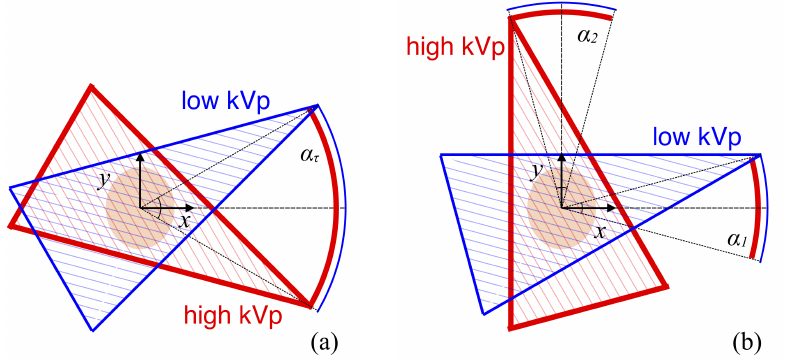
Figure 1. Schematics of SA ( a ) and TOA ( b ) scans of LARs in fan-beam DECT. The SA scan includes a pair of completely overlapping arcs of LAR α τ , and the x -axis intersects with the middle point of the two arcs, whereas the TOA scan includes two pairs of completely overlapping arcs of LARs α 1 and α 2 , and the x - and y -axis intersect with the middle points of the two pairs of arcs. For each pair of the completely overlapping arcs in the SA and TOA scans, low- and high-kVp data are collected over one of the paired arcs. In this work, we consider α 1 = α 2 = 0.5 α τ .